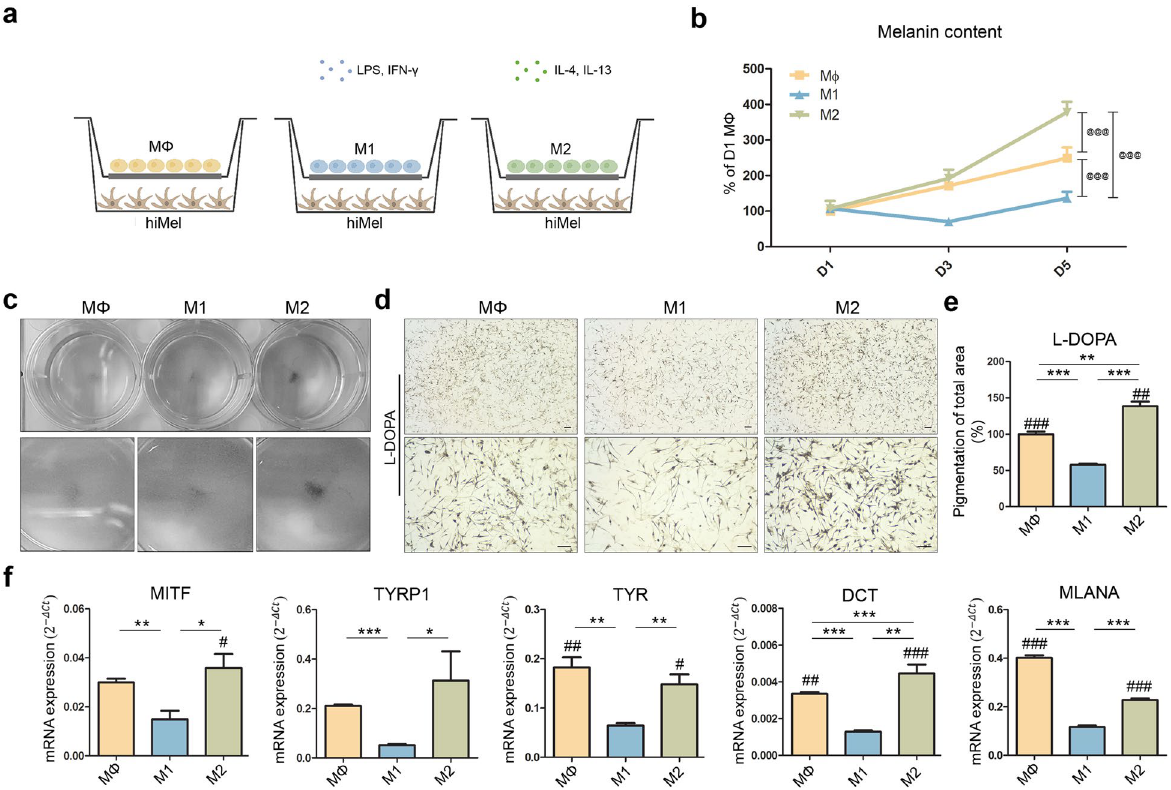
Figure 3. Coculture of hiMels with MΦ, M1, and M2 macrophages in vitro. ( a ) Schematic diagram showing coculture of hiMels and polarized macrophages. ( b ) Melanin content of cocultured hiMels measured on days